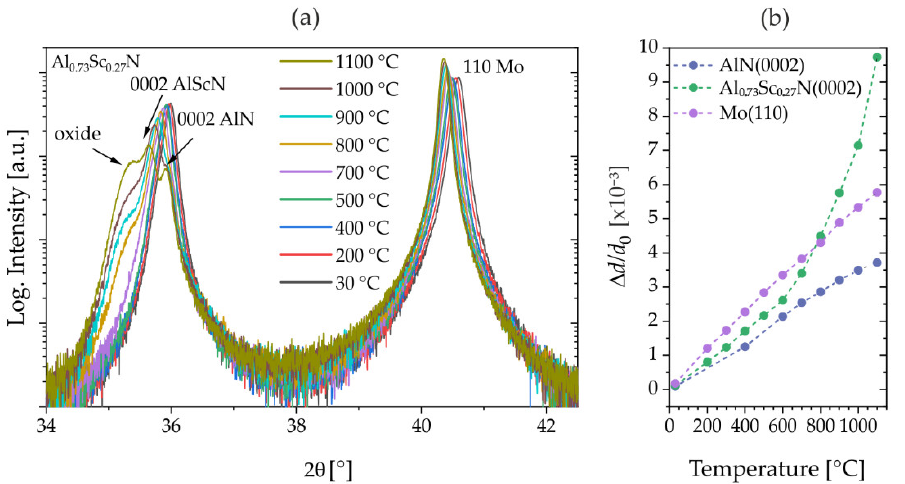
Figure 1. XRD in situ (with oxygen atmosphere) annealing experiments on Al 0.73 Sc 0.27 N and AlN thin films grown on Mo(110)/AlN(0001)/Si(001) (sample set #1). ( a ) 2θ/θ-scan: Evolution of 0002-reflection profile of Al 0.73 Sc 0.27 N and ( b ) relative changes in lattice spacings d with temperature calculated from AlN(0002) and Al 0.73 Sc 0.27 N(0002)/Mo(110)-reflections.